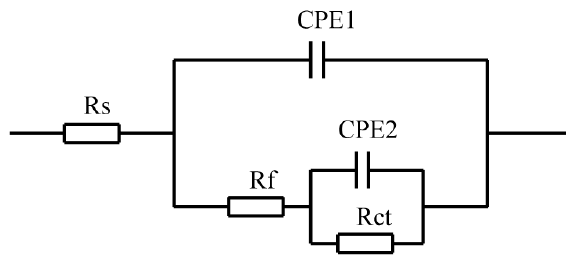
Figure 4. Nyquist EIS spectra of 35CrMoV in artificial seawater solution.